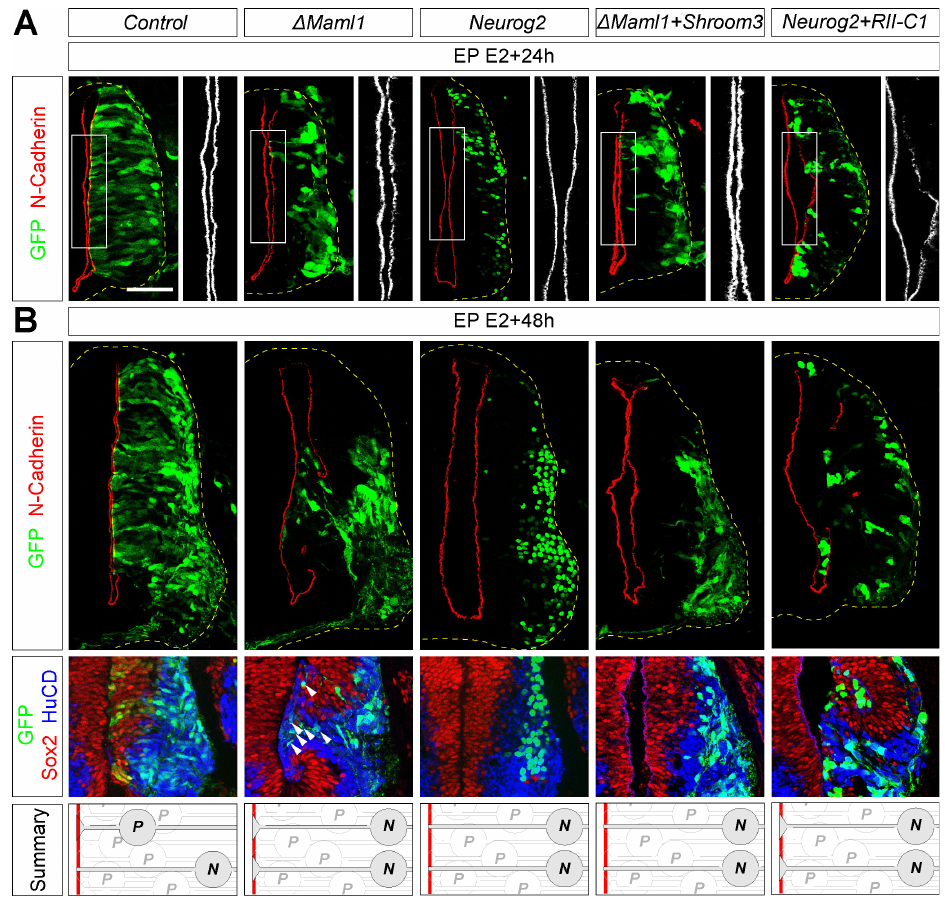
Fig 3. Effects of Notch signaling and apical constriction modulators on apical markers and tissue integrity. (A) Transverse sections of the NT transfected at E2 with the indicated constructs, harvested at E3 and immunostained for N-Cadherin (red). (B) Transverse sections of the NT transfected at E2 with the indicated constructs, harvested at E4 and immunostained for N-Cadherin (red); and for Sox2 (red) and HuCD (blue) to label progenitors and neurons, respectively. Transfection is reported by GFP expression. Summary: Schematic of the effects observed on tissue integrity. Gray cells correspond to electroporated cells. Scale bar represents 50 μ m. See also S4 Fig. Δ Maml1, dominant-negative Mastermind-like 1; E, embryonic day; EP, electroporation; GFP, green fluorescent protein; HuCD, neuron-specific RNA-binding proteins HuC and HuD; N, neuron; Neurog2 , Neurogenin 2 ; NT, neural tube; P, progenitor; RII-C1 , Shroom3 binding site on ROCK2 ; Shroom3 , Shroom family member 3 ; Sox2, SRY (sex determining region Y) box 2.